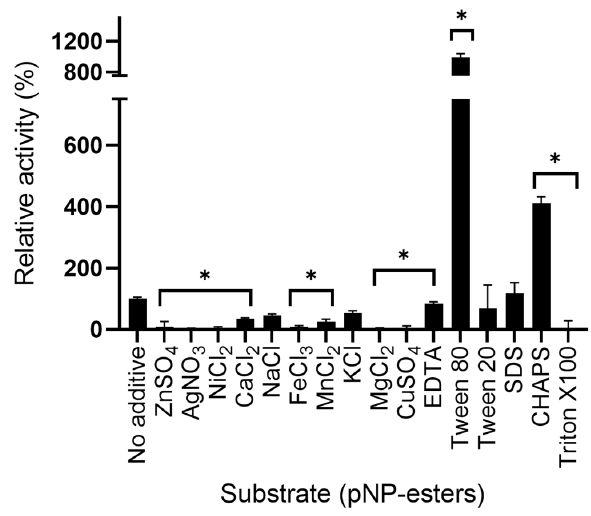
Figure 7. Effect of additives on LipB12_A11 lipolytic activity towards pNP-Laurate relative to the no additive control. Asterisks represent a p -value < 0.05 for the t-test statistical analysis. The 100% activity is 1.35 × 10 − 5 U/µL.